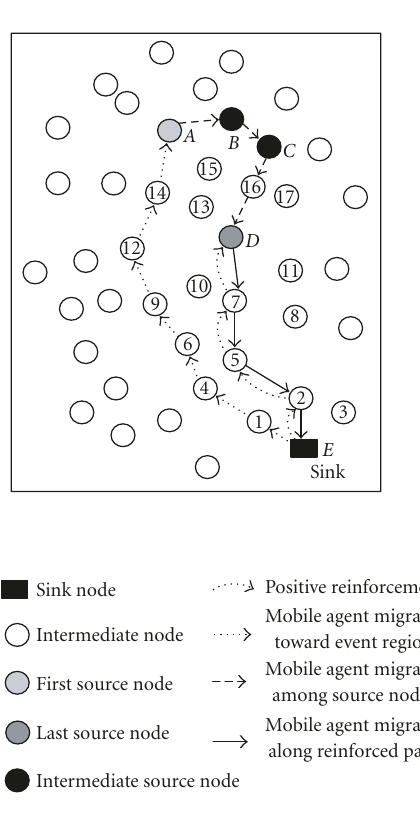
Figure 5: Second phase of